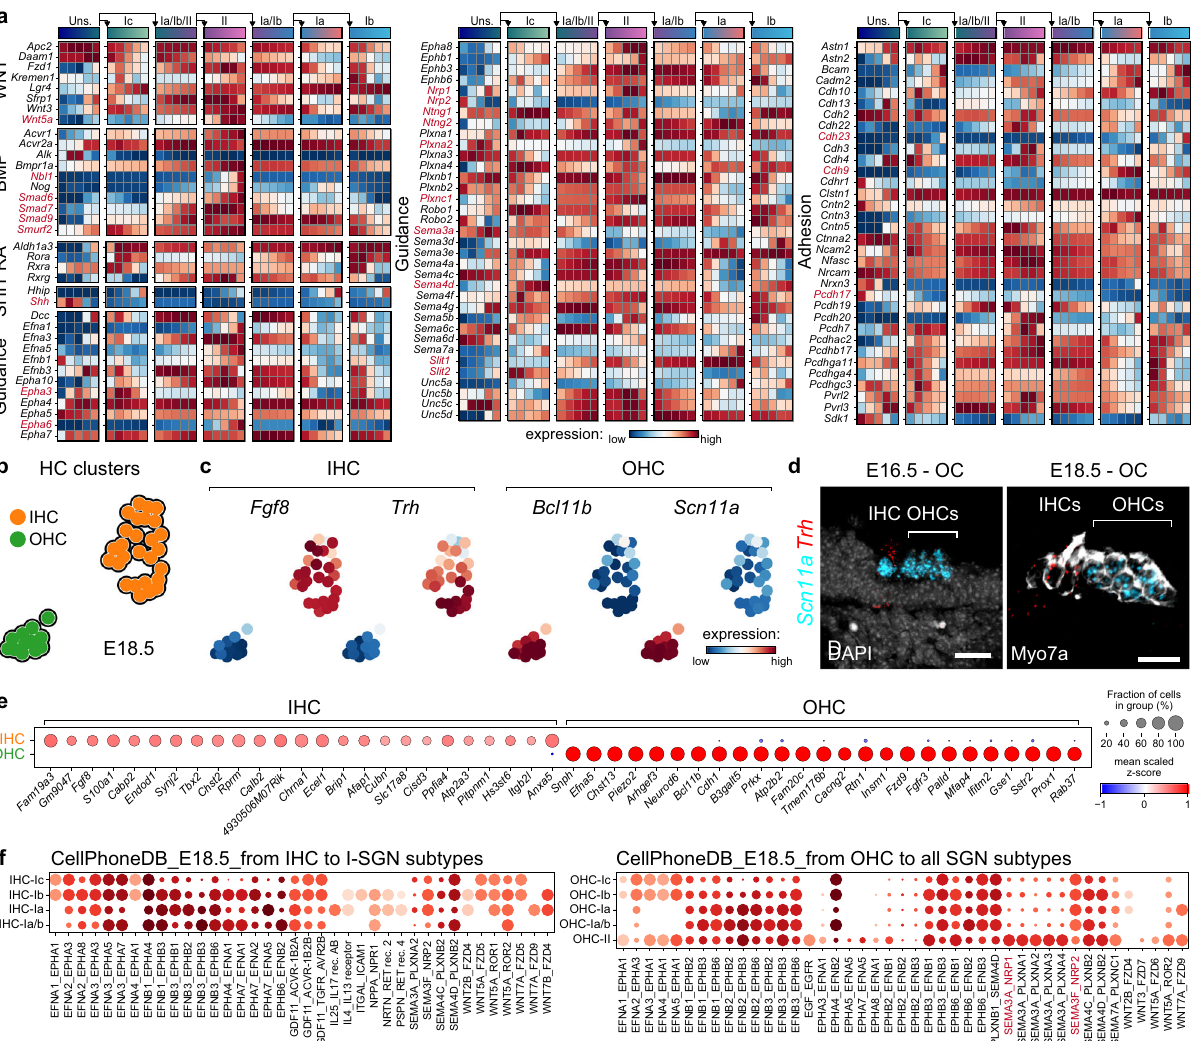
Fig. 5 Cell – cell communication signatures de fi ning SGN differentiation. a Expression of genes linked to morphogen signaling, axon guidance and cell adhesion in each neuronal trajectory (see also Supplementary Fig. 4 and 5). The color bars at the top indicate cell states as in Fig. 2a. b tSNE plot of the IHC and OHC clusters at E18.5. c Representation of selected genes speci fi c to IHC ( Fgf8 and Trh ) and OHC ( Bcl11b and Scn11a ) on the tSNE plot. d In vivo con fi rmation of Scn11a and Trh expression in HCs at E16.5 and E18.5 using immunohistochemistry and in situ hybridization (RNAscope). Note that Scn11a is a general marker for both HC types at E16.5. e Dot-plot of the top 25 DEGs between IHC and OHC at E18.5. f CellPhoneDB analysis of the top selected potential outgoing cell-to-cell signalling from HCs to SGNs (see also Supplementary Fig. 7). Data in a , c and f represent max normalised fi tted gene expression, Knn smoothed log10(fpm) expression and log2 mean of (interacting molecule 1, interacting molecule 2), respectively. Genes referenced through the text are highlighted in red in a and f . Scale bar: 20 µ m. OC organ of